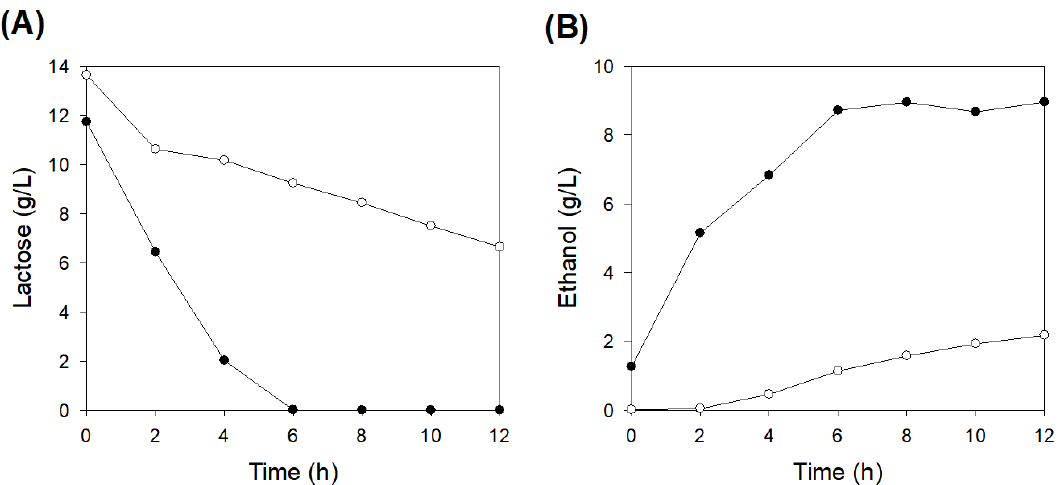
Figure 2. The impact of pre-activation of immobilized K . lactis . Lactose consumption ( A ) and ethanol production ( B ) differences of immobilized K . lactis cells with or without pre-activation. Filled circle, immobilized cells with pre-activation; open circle, immobilized cells without pre-activation.